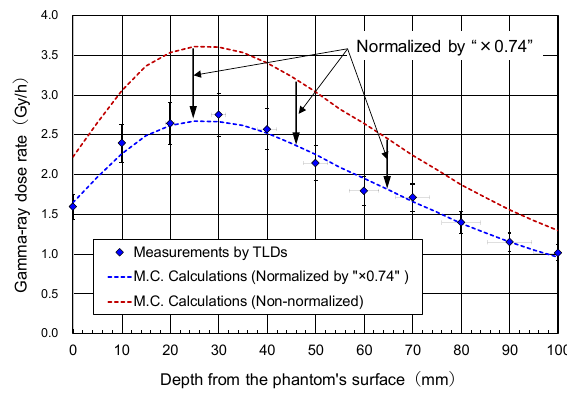
Fig. 5 Gamma-ray dose rate on the beam